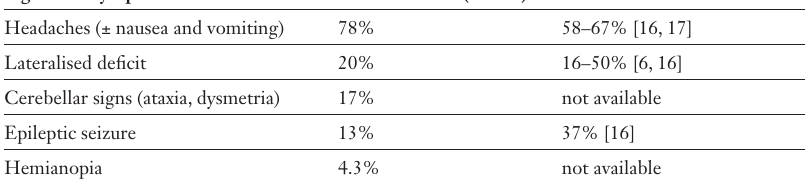
Table 4 Signs and symptoms of children with spon- taneous cerebral haemorrhage in this case series and in the